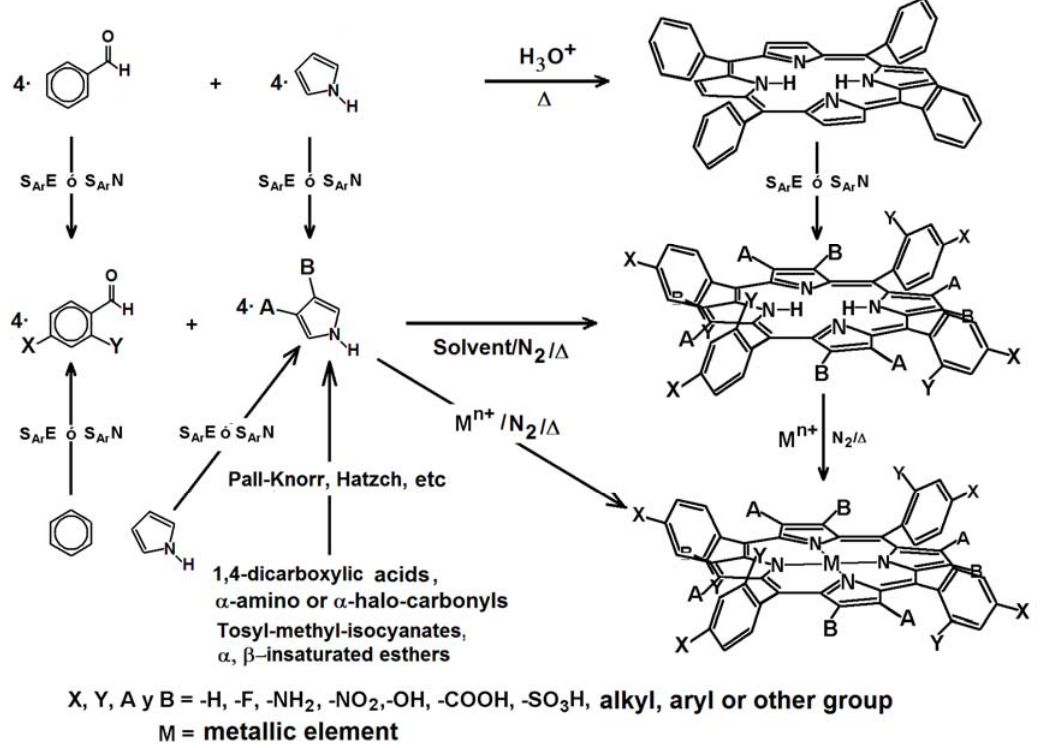
Figure 11. Possible routes to synthesize porphyrins with diverse groups at the A and B positions of pyrroles, or with substituted phenyls attached to the bridge methane